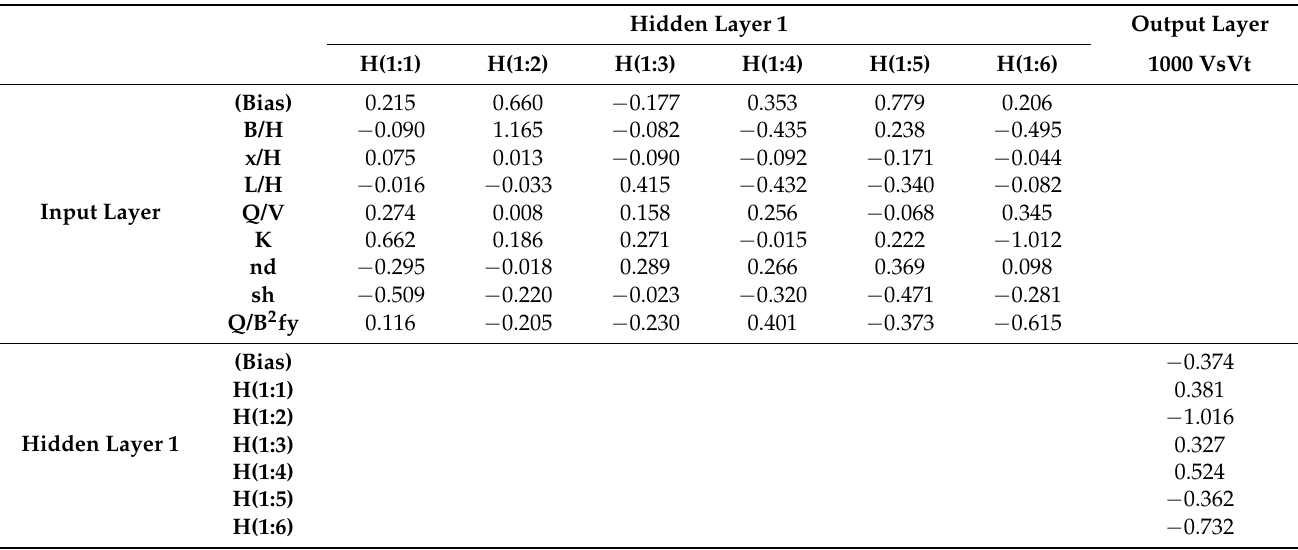
Figure 4. Layout for the developed ANN and its connection weights. Table 4. Connection weights for the developed